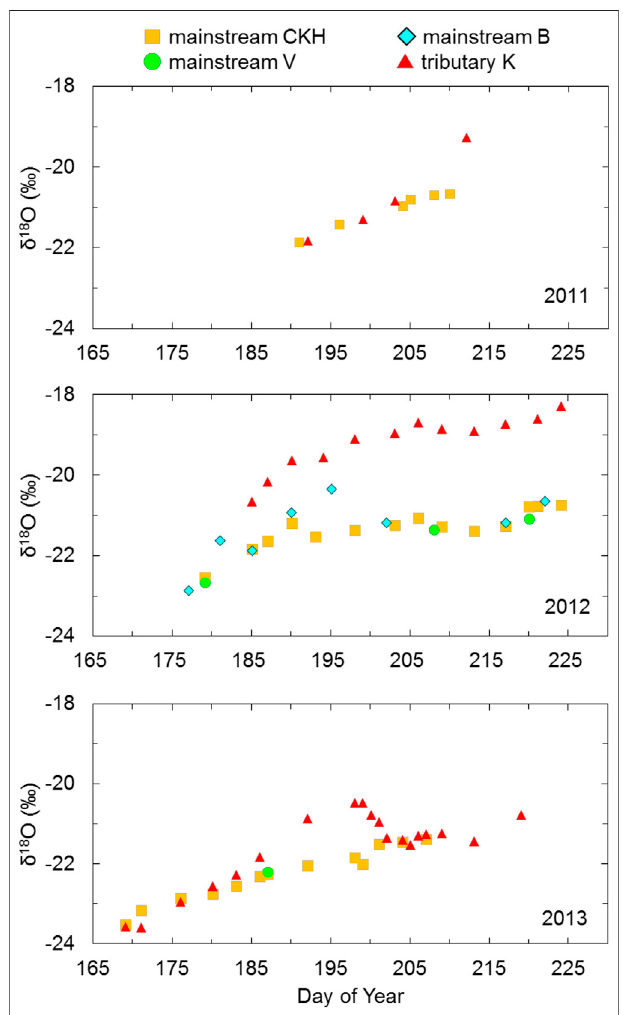
FIGURE 3 | Time series for δ 18 O grouped to the Indigirka mainstream and tributary during summer in 2011 – 2013. The mainstream samples were observed at sampling points CKH, B, and V, and the tributary samples were observed at point K.